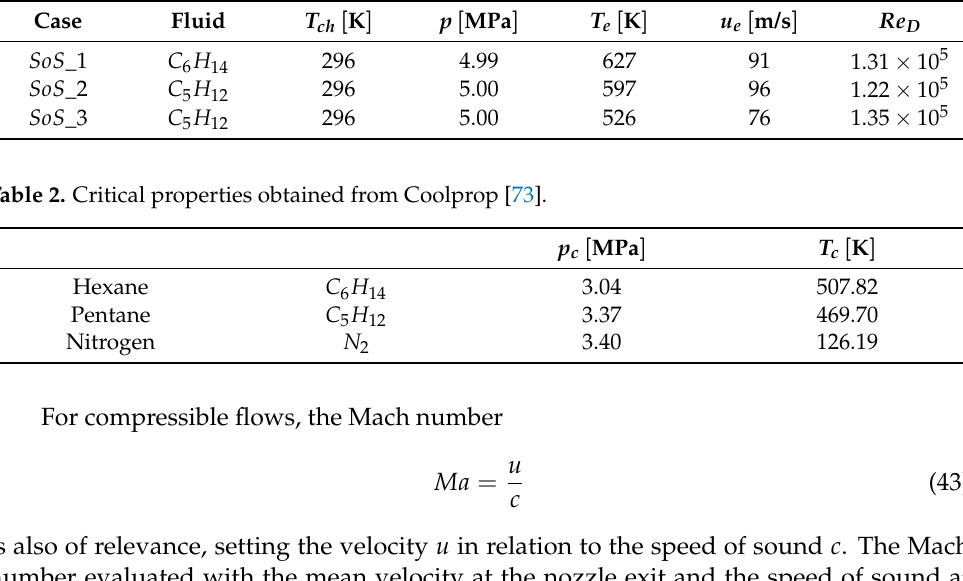
Table 1. Considered configurations. T ch , p , T e , u e , and Re D denote the chamber temperature, the chamber pressure, the temperature and the mean velocity at the nozzle exit, and the Reynolds number.